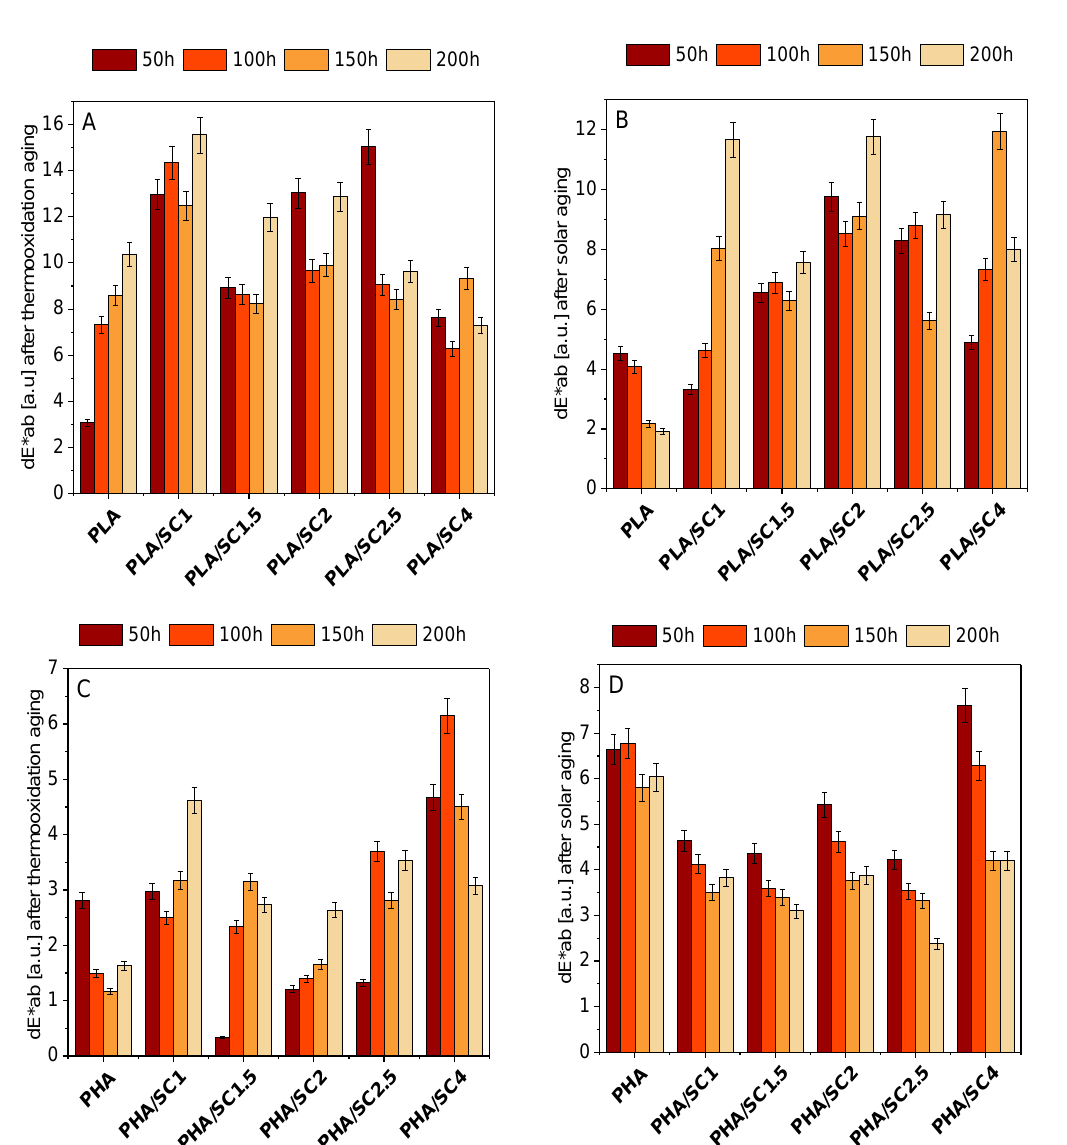
Figure 8. The changes in color of PLA ( A , B ) and PHA ( C , D ) with succinic acid (SC) after thermooxidation and solar aging.